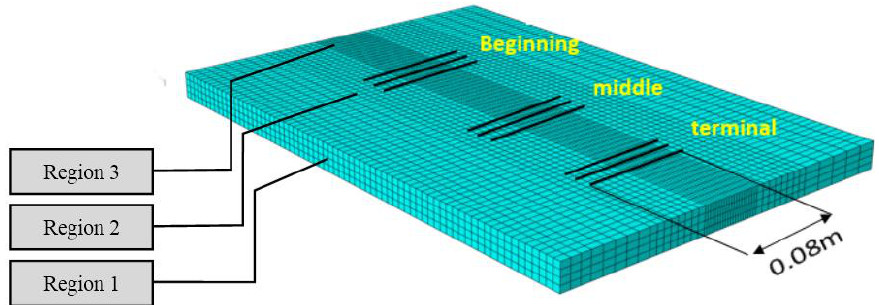
Figure 7. Three positions were analyzed in terms of the transverse residual stresses: beginning, middle and terminal; at each position, the average values based on three reference lines 80 mm long and 0.045 mm equidistant from each other were used.